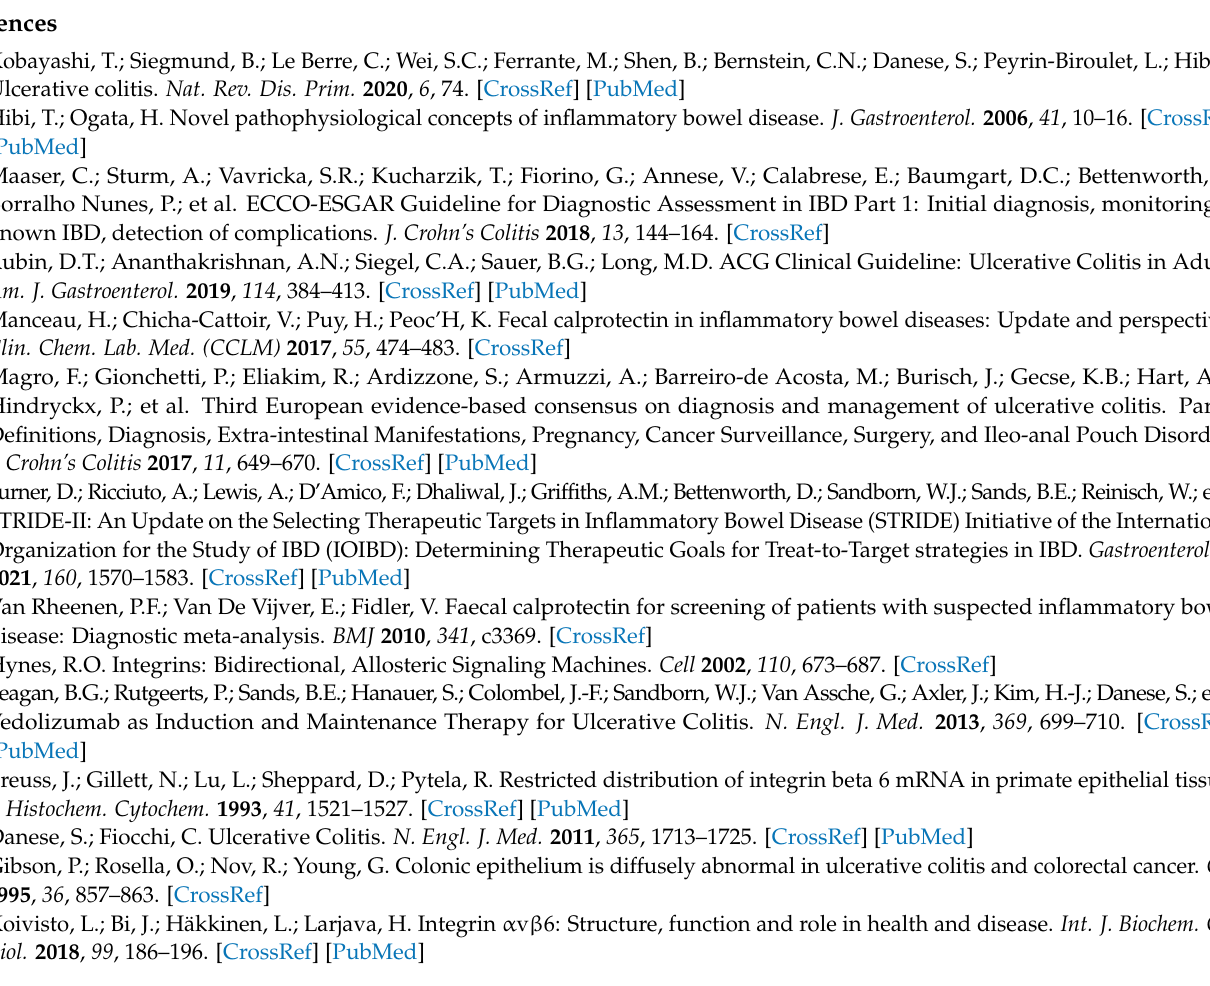
Table S2: IBS patient characteristics; Table S3: Diagnostic performance of fCP in diagnosis of IBD with the entities UC and